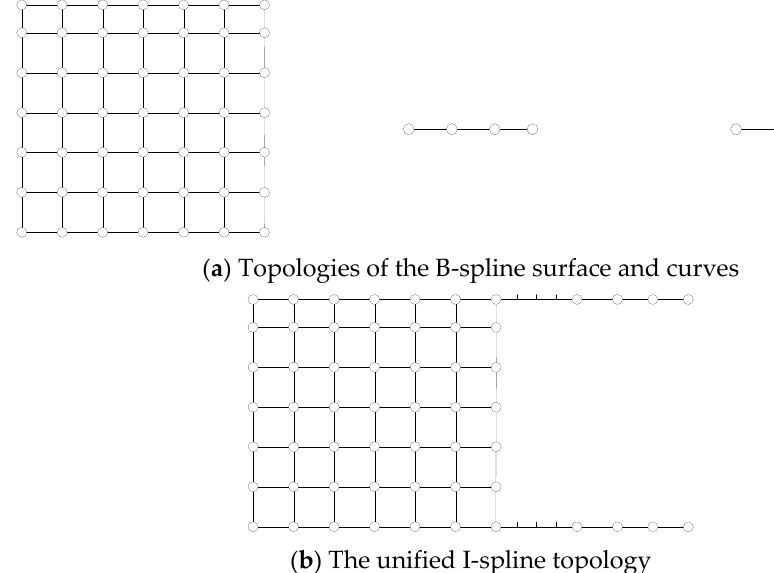
Figure 12. Unified representation of the B-spline surface and curves of the car model.